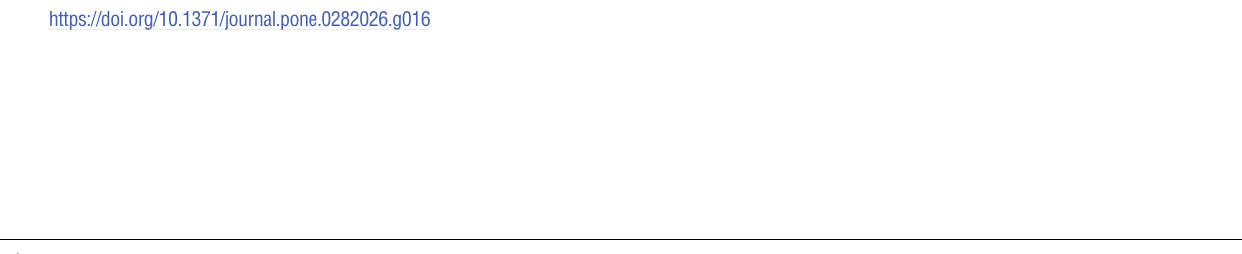
PLOS ONE | https://doi.org/10.1371/journal.pone.0282026 February 21,